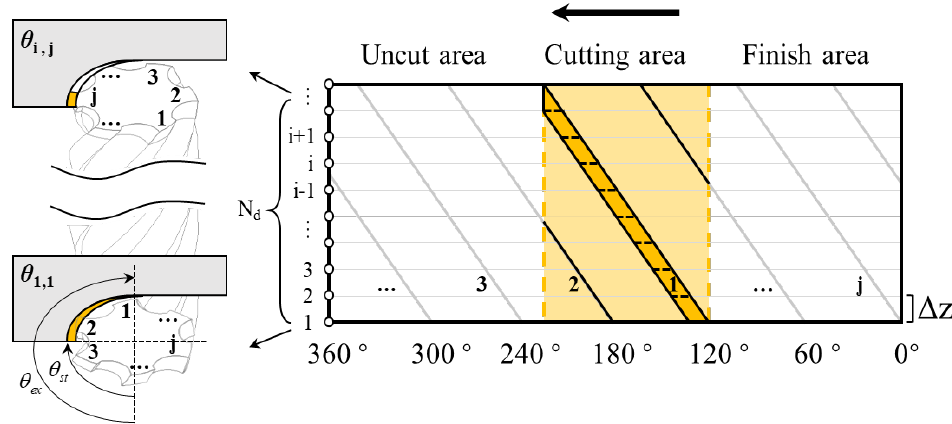
Figure 2. Expansion of the cutter-workpiece engagement.